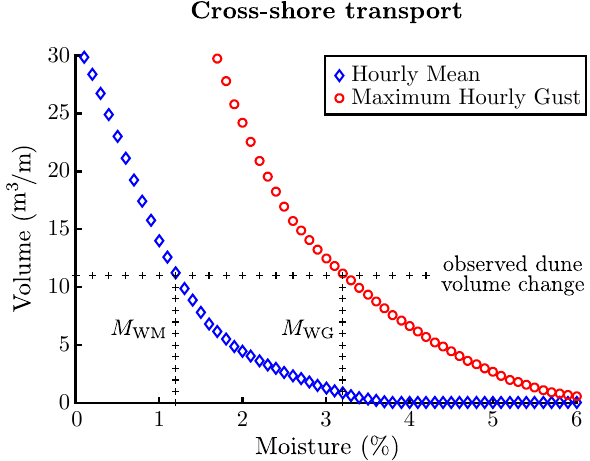
Figure 12. Calculated cross-shore sand transport from the intertidal beach as a function of moisture content (M), for the period 18 March 2009–11 March 2010. Moisture values M WM and M WG correspond to the moisture values for which calculated transport matches observed dune volume change (during the same period) for hourly wind mean and hourly wind gust